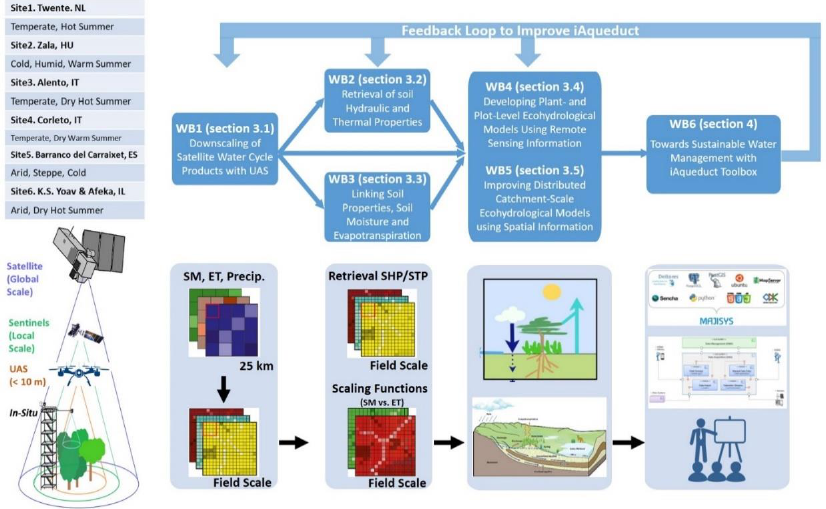
Figure 1. Theoretical framework of iAqueduct: the interconnected working blocks (WBs) and the corresponding sections, with the study sites listed.